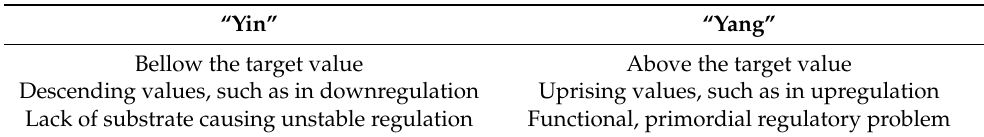
Table 1. Meanings of “yin yang” within the regulatory context (adapted with permission from Greten, H. (2008). Copyright 2008 Heidelberg School of Chinese Medicine [10]).